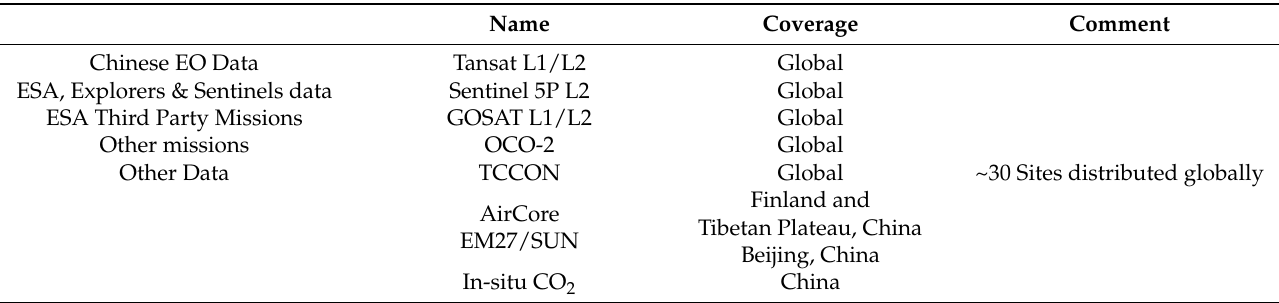
Table 3. EO and other datasets utilised in this